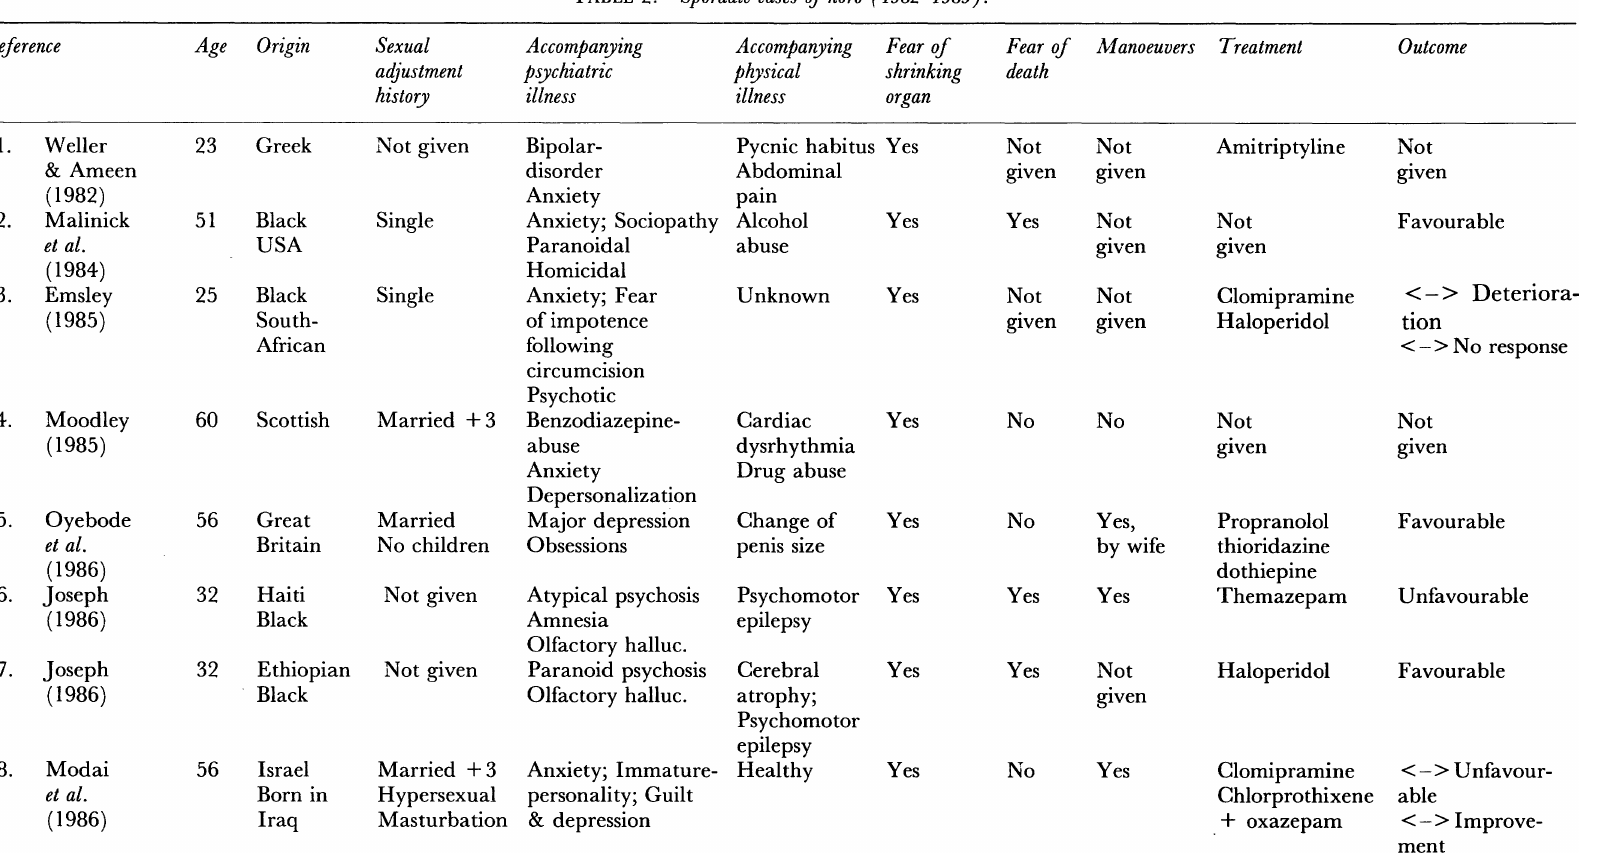
TABLE 2. Sporadic cases of koro